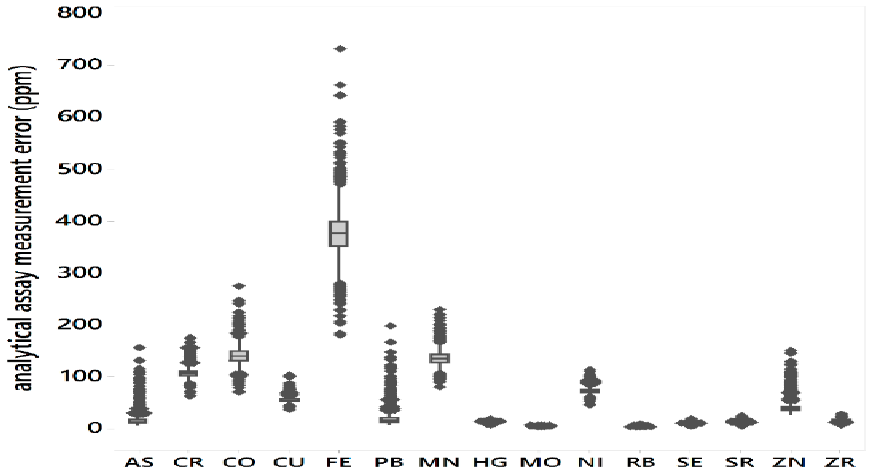
Figure A1. Sample analytical assay measurement error